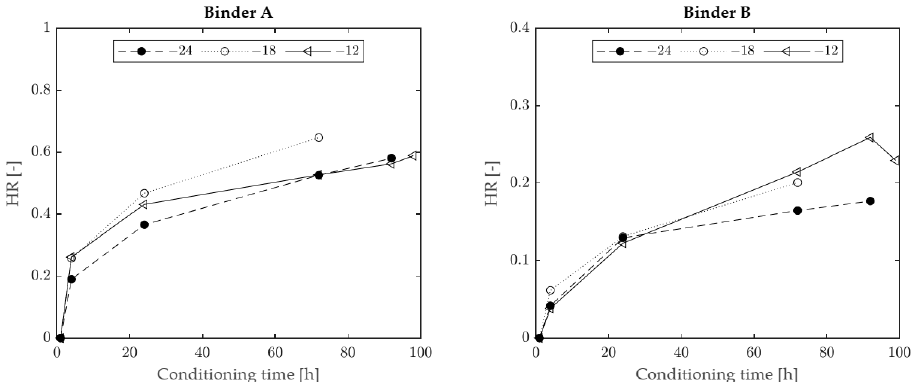
Figure 3. Hardening rate as a function of conditioning time (experimental data).